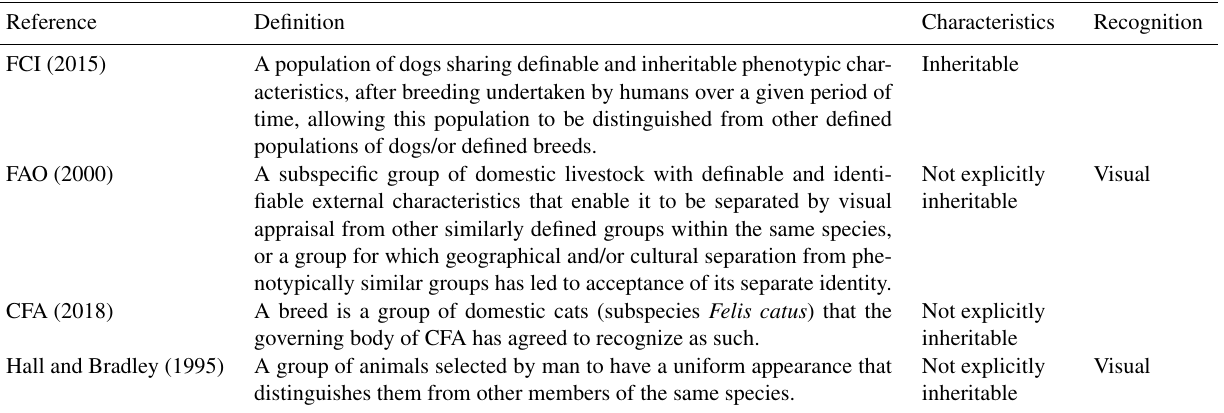
Table 1. This table outlines the differences of the four word-based breeding definitions. All definitions have the fact in common that all individuals of a breed must belong to the same